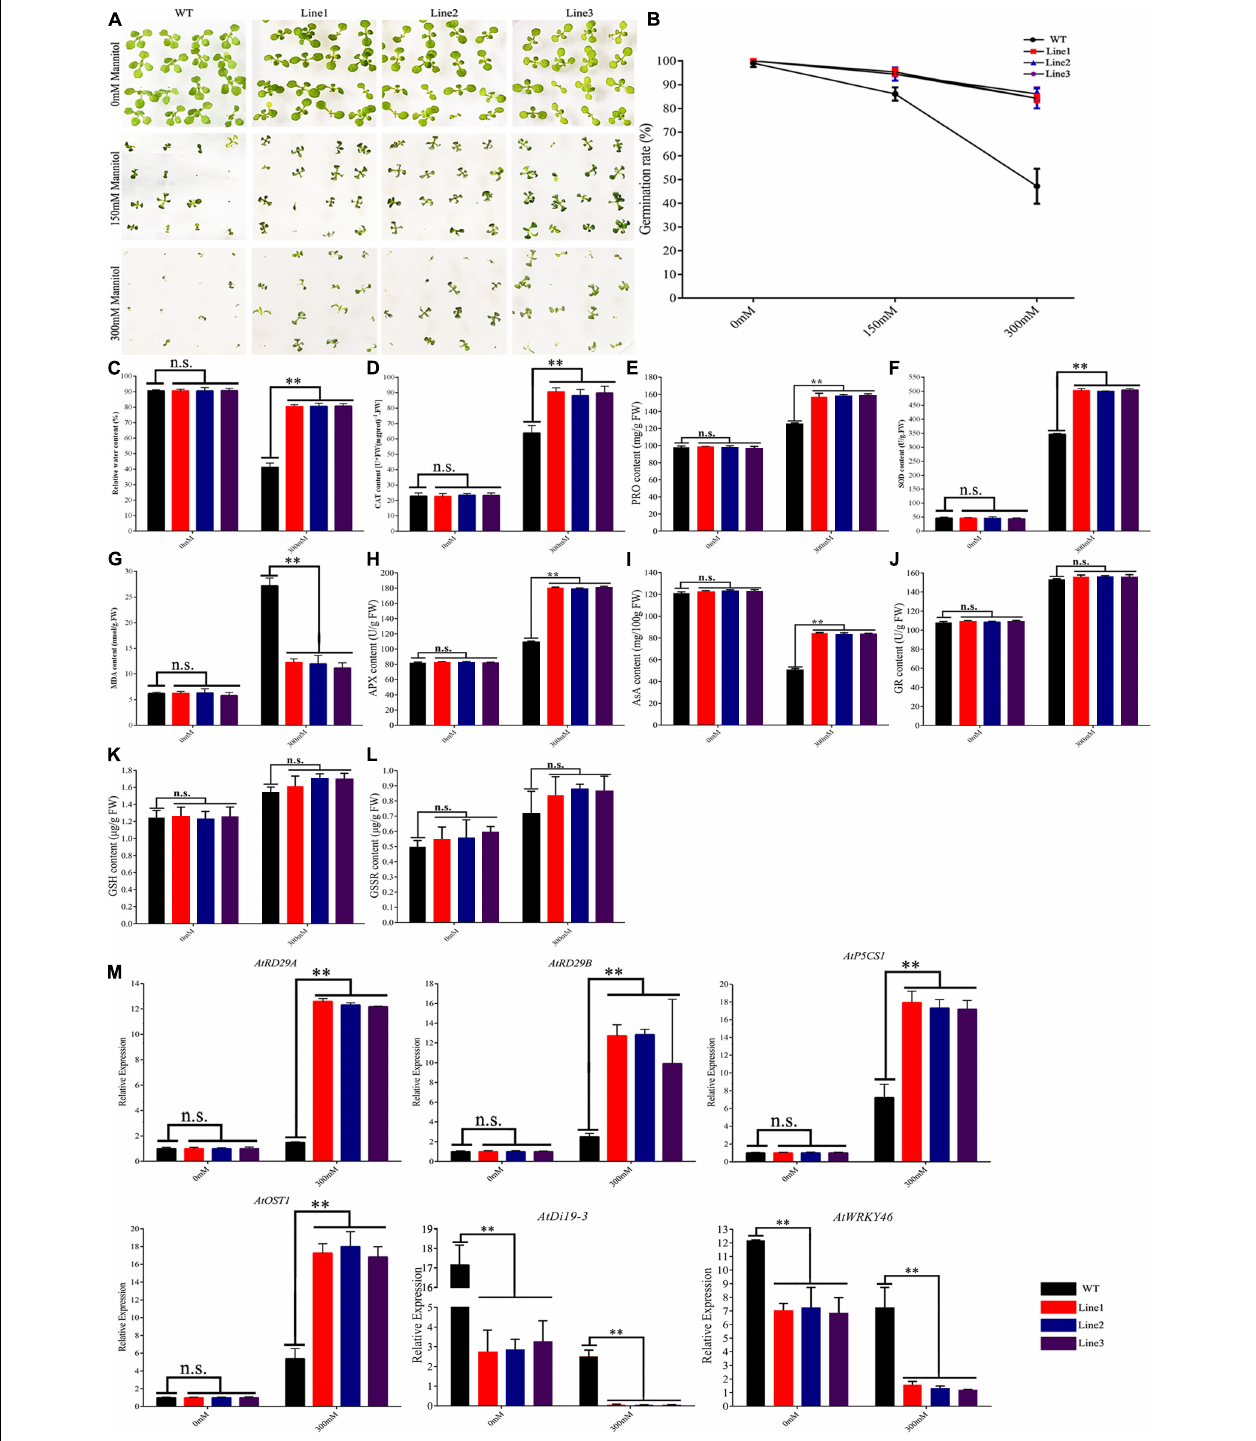
FIGURE 5 | Germination phenotypes of TaVQ14 in transgenic Arabidopsis plants under drought stress. (A) Germination performance of TaVQ14 -overexpressing and wild-type (WT) seeds on Murashige and Skoog medium containing 0, 150, or 300 mM of mannitol. (B) Rate of germination in transgenic and WT seeds. (C–L) Relative water content (C) , and levels of catalase (D) , proline (E) , superoxide dismutase (F) , malondialdehyde (G) , Ascorbate Peroxidase (H) , Ascorbic acid (I) , Glutathion Reductases (J) , L-Glutathione (K) , and L-Glutathione oxidized (L) in transgenic and WT plants after drought treatment. Values are means ± SE ( n = 3). ∗ P < 0.05 ∗∗ P < 0.01 ( t -test). (M) Relative expression levels of drought-responsive genes in transgenic A. thaliana plants under normal water conditions. Leaves of transgenic and WT plants were collected after drought stress. Y-axis: relative expression levels; X-axis: the time course of stress treatments; Error bars, 6 ± SE.